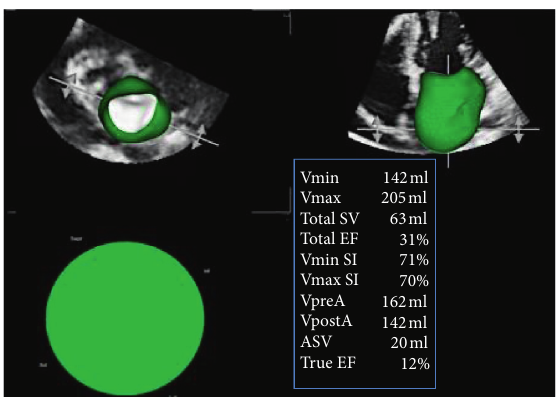
Figure 2: Left atrial quantitative analysis using 3D transthoracic echocardiography in a patient with dilated cardiomyopathy and functional mitral regurgitation.